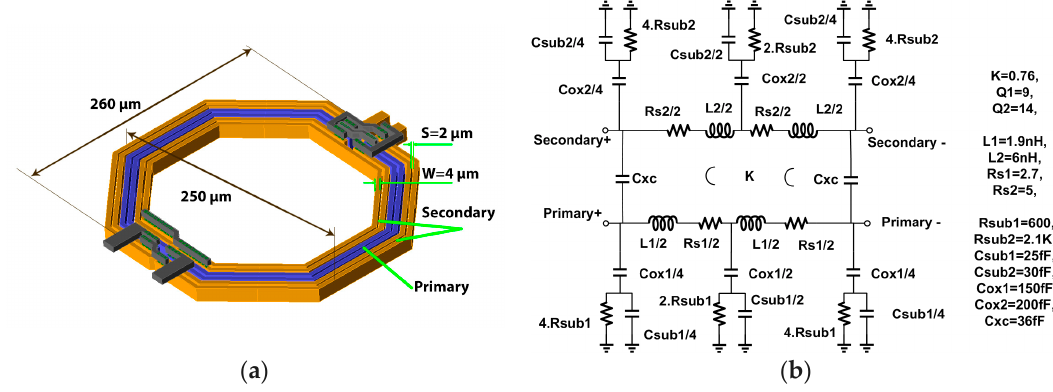
Figure 5. ( a ) Layout of transformer and ( b ) Lumped model.